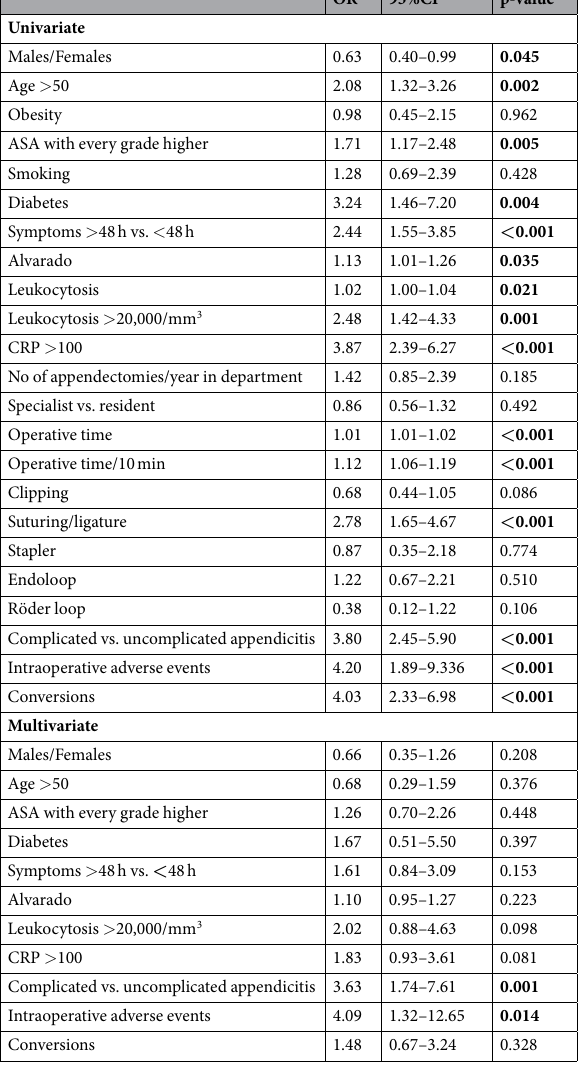
Table 2. Risk factors for perioperative serious complications (C-D